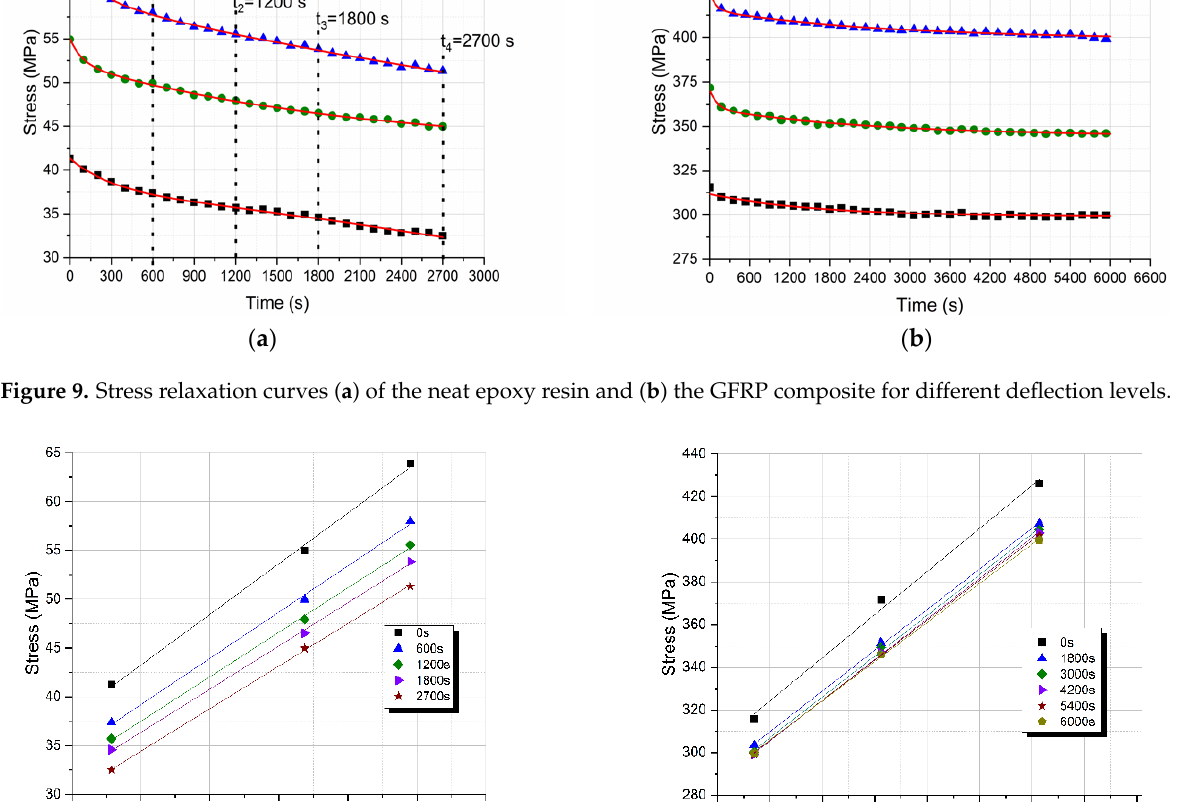
Figure 9. Stress relaxation curves ( a ) of the neat epoxy resin and ( b ) the GFRP composite for different deflection levels.